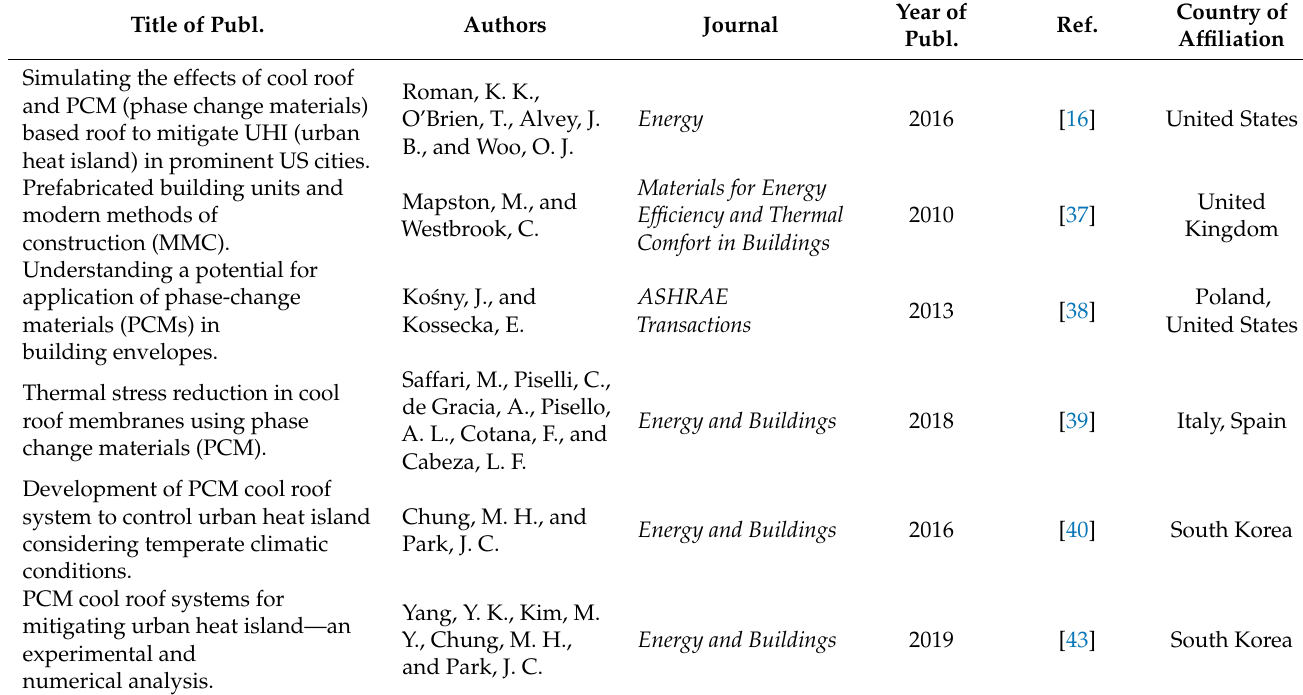
Table 3. Most important publications about